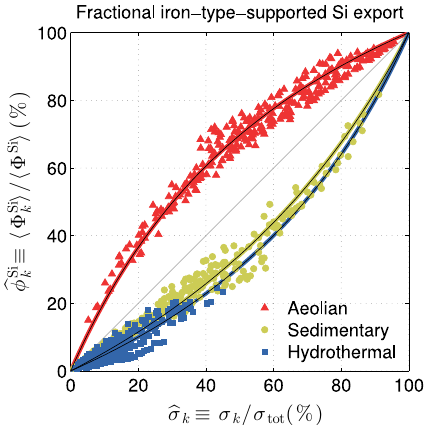
Figure 10. Percent global opal export supported by each iron type (aeolian, sedimentary, hydrothermal) versus the corresponding frac- tional source of that iron type. Lines represent fits to theoretical curves with fixed relative export-support efficiencies. (See text for